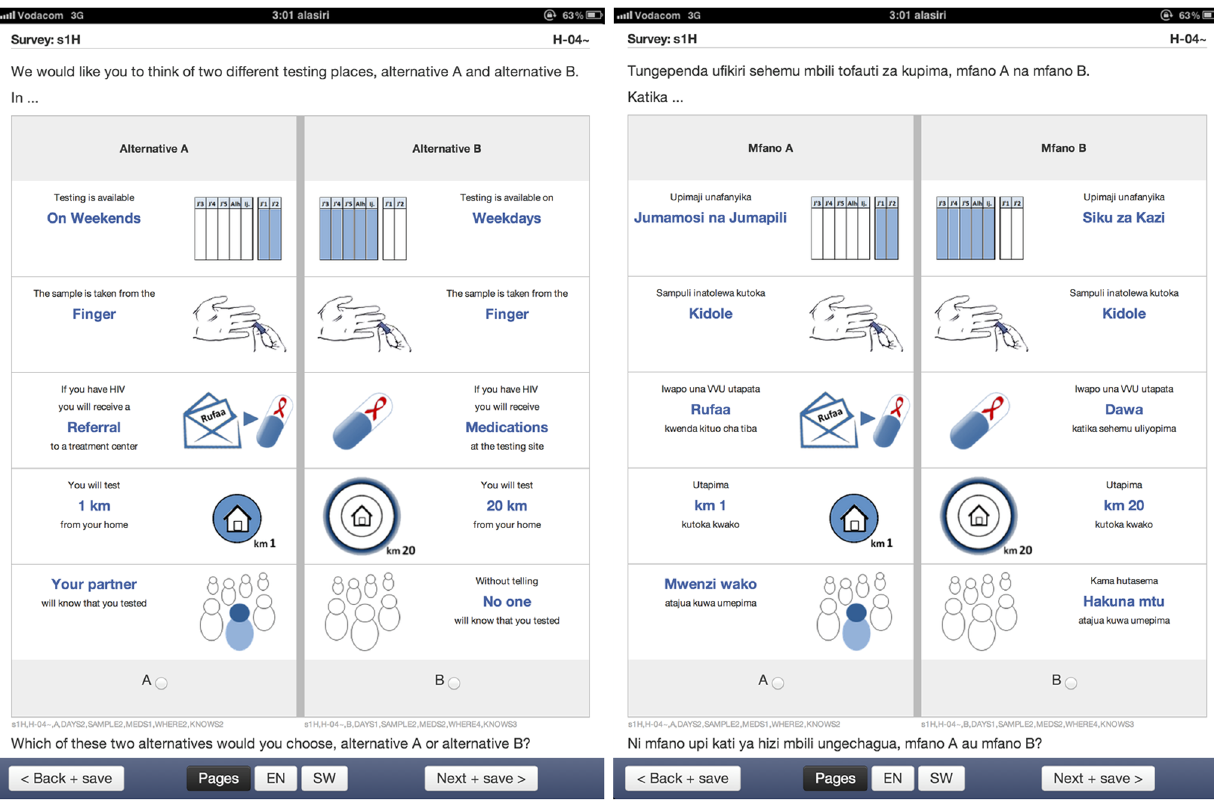
Figure 1. Sample choice task. Choice task shown to participants during the iPad-based presentation of the discrete choice experiment, in English (left) and Kiswahili (right).